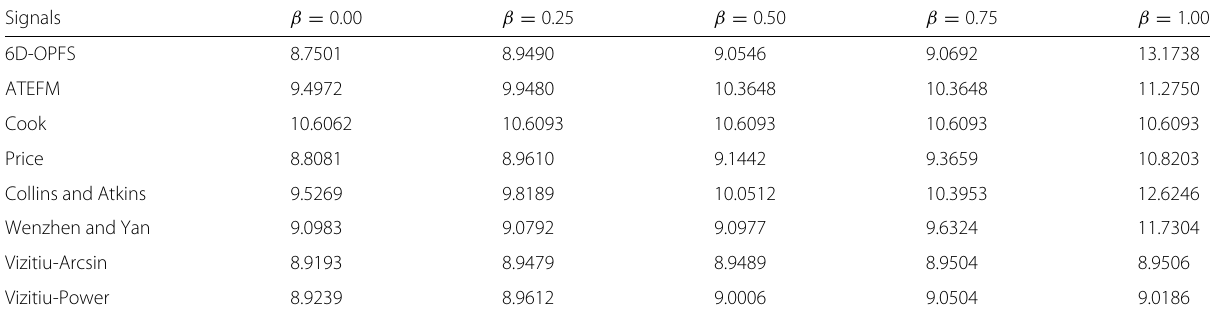
Table 3 ISLR of the parameterized signals computed with the parameters obtained from optimization routines